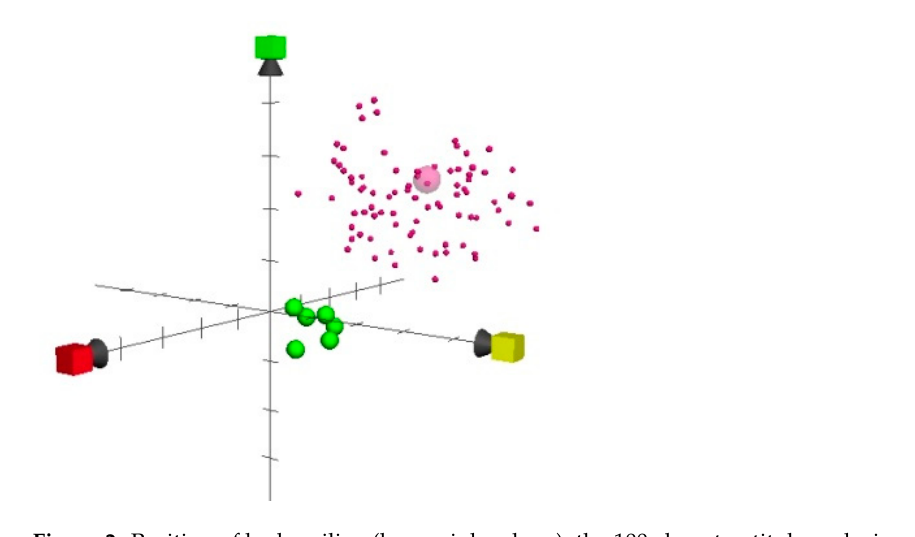
Figure 2. Position of bedaquiline (large pink sphere), the 100 closest antituberculosis compounds (small spheres), and quinoline compounds (green spheres), using ChemGPS-NP scores, where PC1 (x = red), PC2 (y = yellow), and PC3 (green).